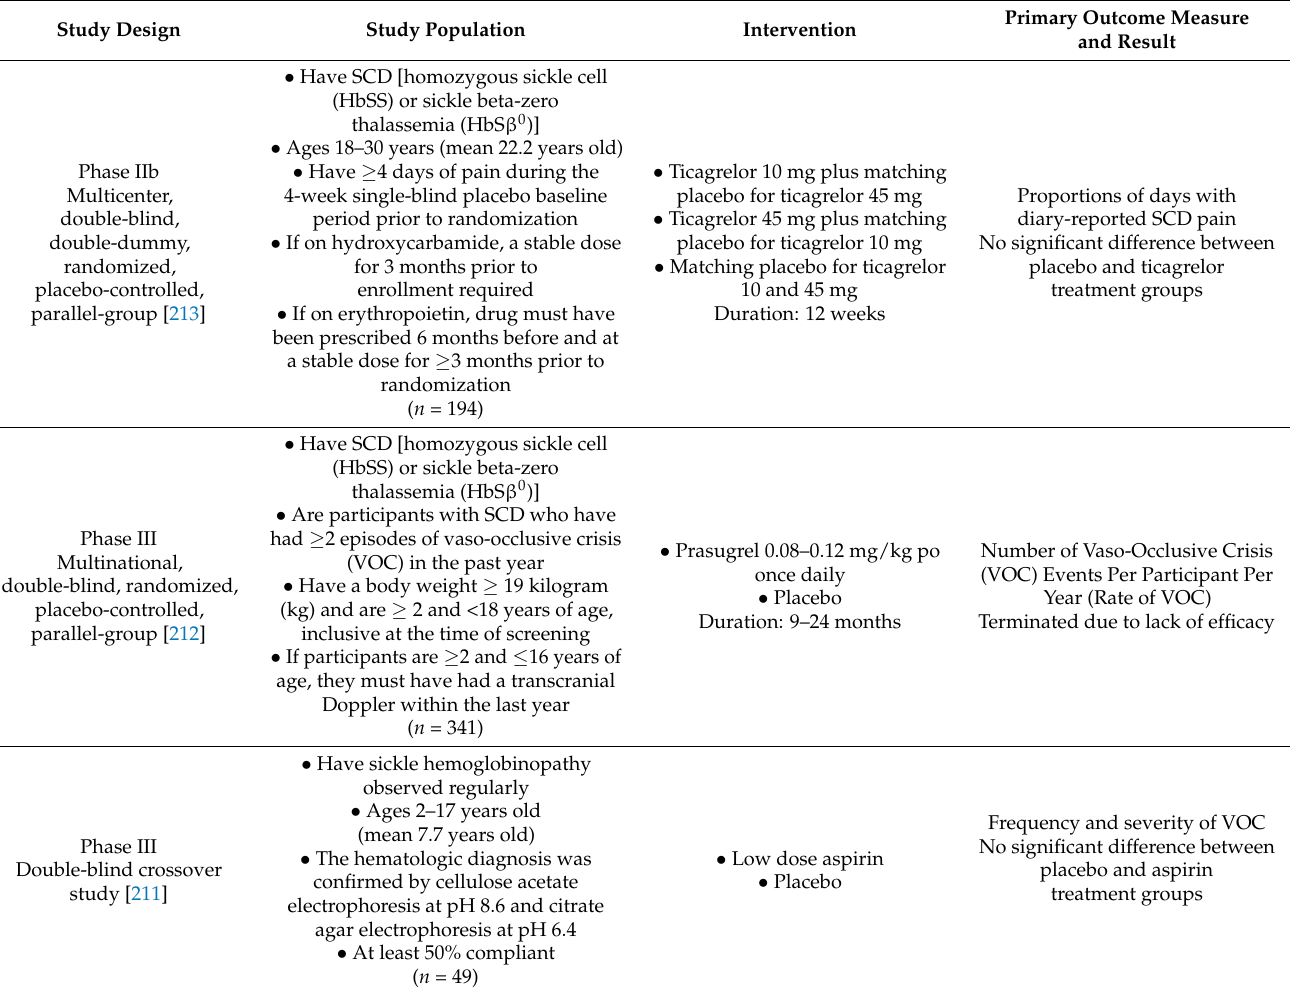
Table 3. Efficacy trials of antiplatelet therapies in